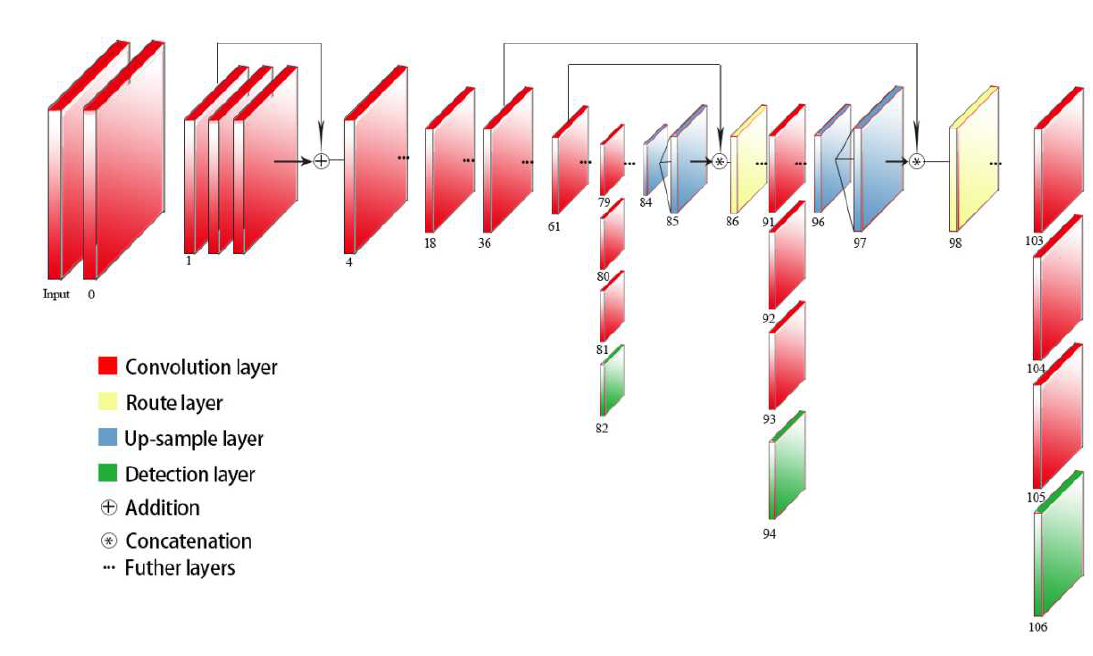
Figure 3. Network structure of you only look once